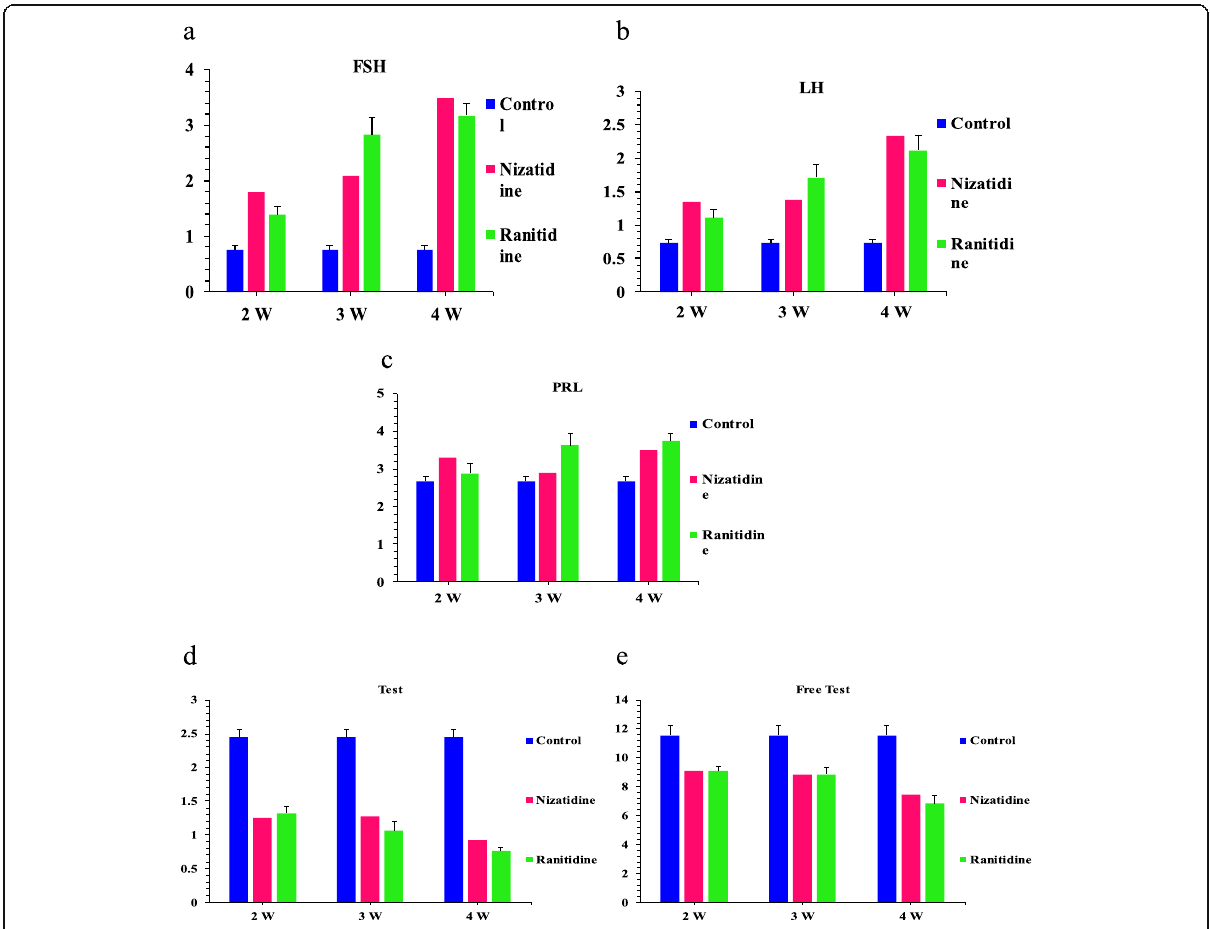
Fig. 8 a Effects of oral administration of nizatidine, ranitidine (27 mg/kg b. wt.) given once a day for 4 weeks on serum follicle-stimulating hormone of male albino rats. b Effects of oral administration of nizatidine, ranitidine (27 mg/kg b. wt.) given once a day for 4 weeks on serum luteinizing hormone of male albino rats. c Effects of oral administration of nizatidine, ranitidine (27 mg/kg b. wt.) given once a day for 4 weeks on serum prolactin hormone of male albino rats. d Effects of oral administration of nizatidine, ranitidine (27 mg/kg b. wt.) given once a day for 4 weeks on serum total serum testosterone hormone of male albino rats. e Effects of oral administration of nizatidine, ranitidine (27 mg/kg b. wt.) given once a day for 4 weeks on serum free testosterone hormone of male albino